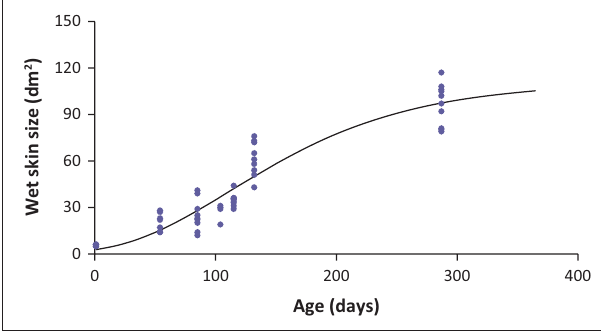
FIGURE 1: A Gompertz model fitted to the wet skin size increase against age for